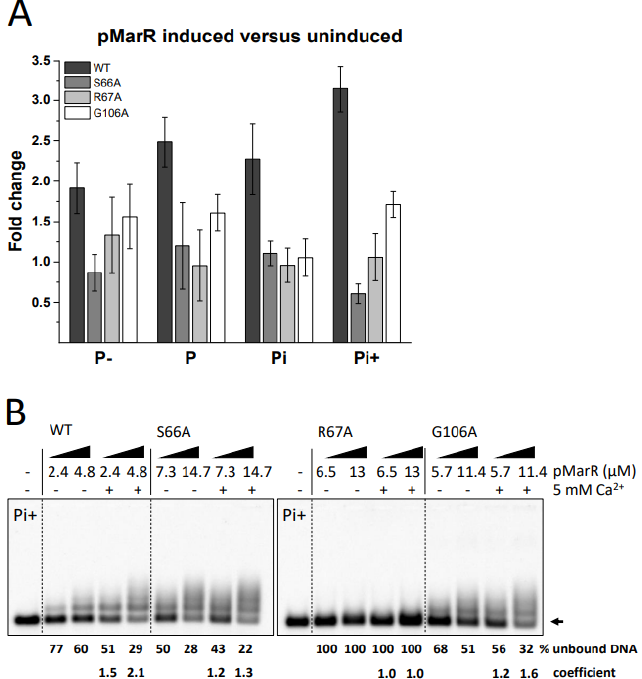
Figure 3. Influence of single amino acid mutations in pMarR on MED4 rne promoter activity. ( A ) GFP fluorescence of E. coli cells harbouring the pXG10-SF plasmid, whose gfp expression is controlled through the analyzed promoter segment and the pQE70 expressing WT or mutants of pMarR. Fold changes were calculated from the average fluorescence values of 50,000 cells per clone from 6 individual clones for each strain, comparing cells that express pMarR (induced with 1 mM IPTG) or do not (uninduced, without IPTG). ( B ) DNA binding of pMarR WT and single amino acid mutants was tested by EMSA using Cy5-labeled rne Pi+ DNA segment. Binding reactions contained two concentrations of recombinant pMarR protein in the presence of 12.5 nM labelled promoter fragment, 1 µg poly (dI-dC) as a non-specific competitor, and 0 or 5 mM Ca 2+ . The arrow indicates the position of unbound DNA. Shift assays without Ca 2+ ions were used for the calculation of the coefficient.